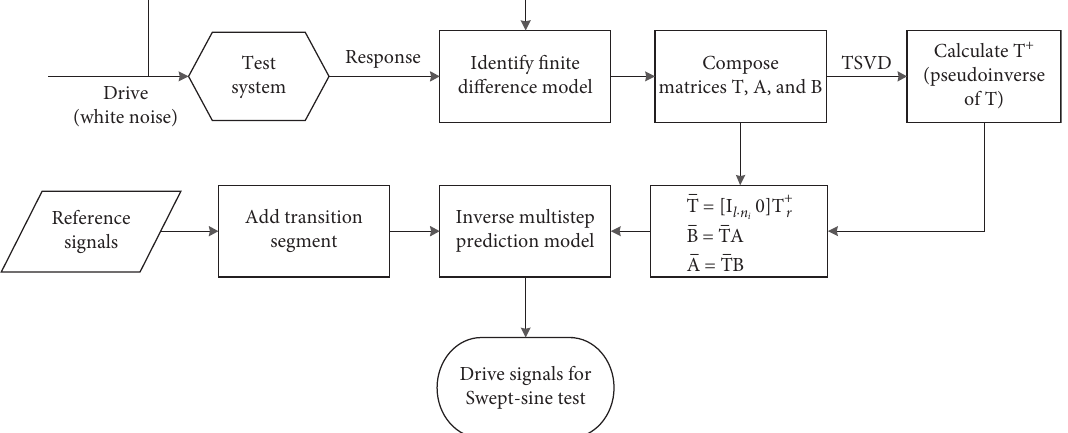
Figure 3: Generation of drive signals for the MIMO swept-sine test.